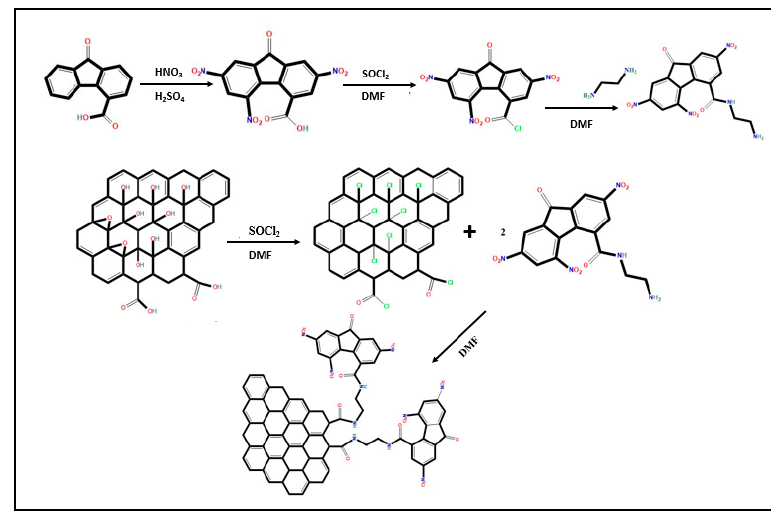
Figure 1. Schematic representation of the chemical synthetic procedure.